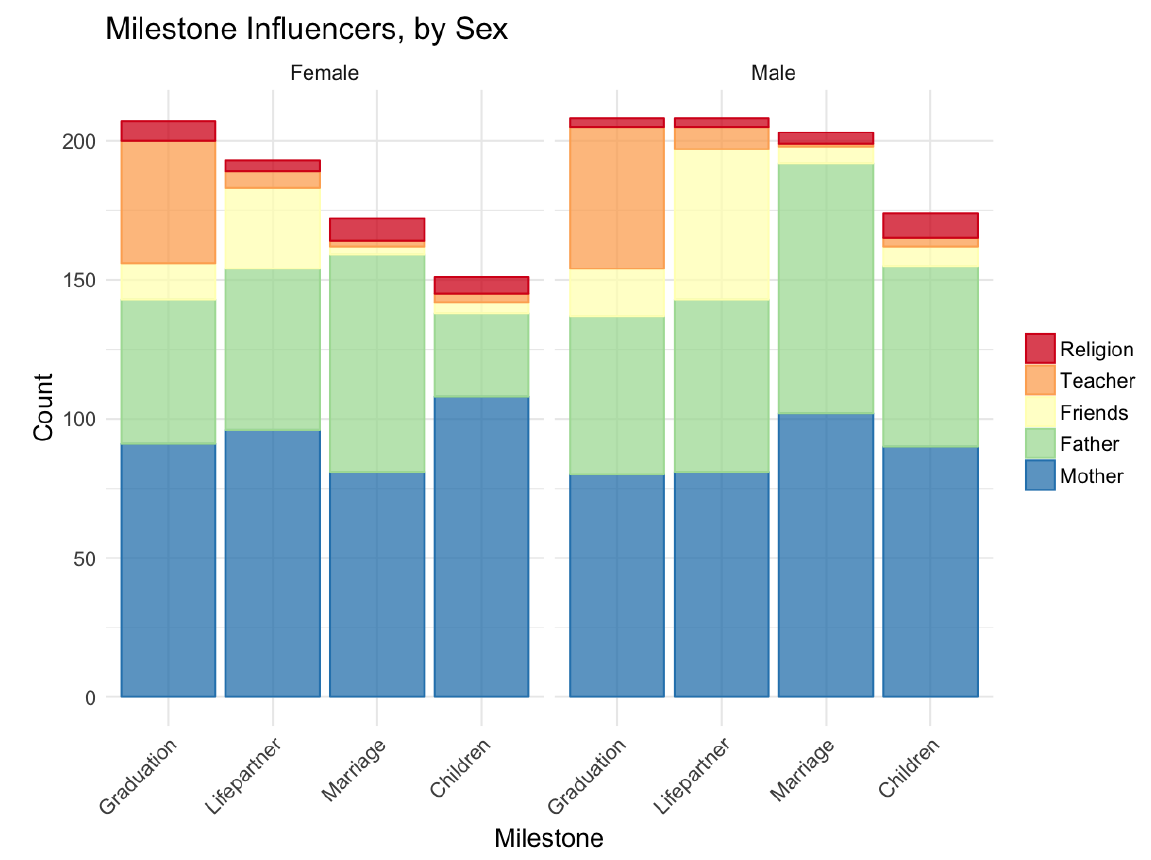
Figure 6. Reported “influencers” for each milestone, by